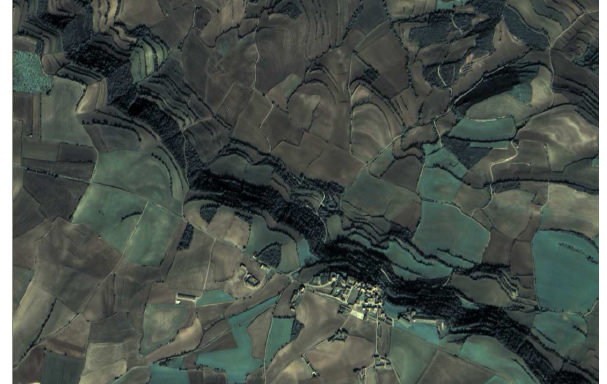
Figure 5. IHS Fused image